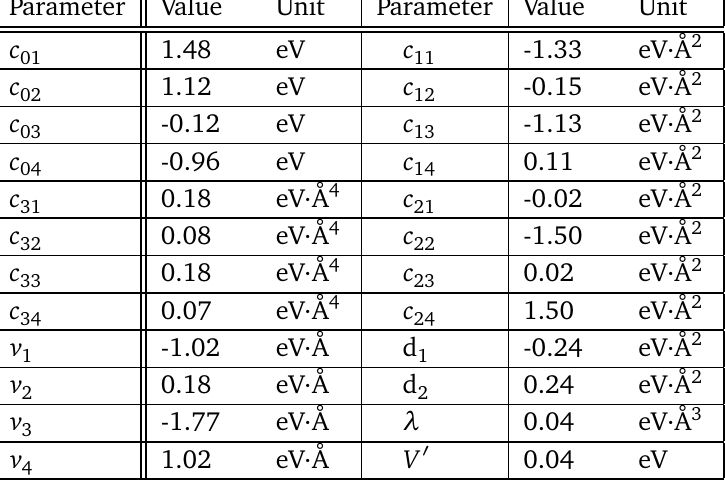
Table 3: Value of parameters for the low-energy model given in Eq. (2). These val- ues are obtained after fitting this low-energy model to the tight-binding model (see Eq.